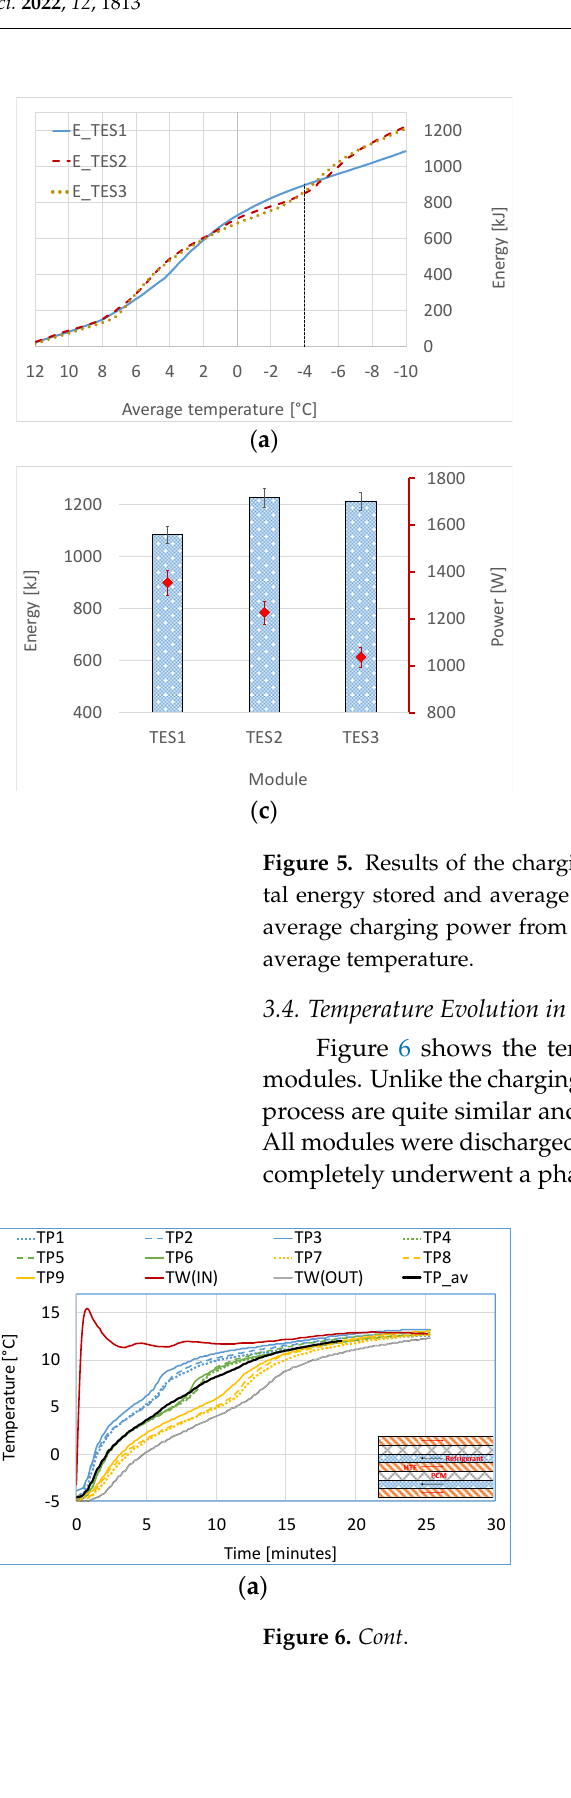
Figure 6. The temperature profiles of the discharging process for ( a ) TES (cid:2869) , ( b ) TES (cid:2870) , ( c ) TES (cid:2871) , and ( d ) position of the temperature sensors. 3.5. Energy Storage and Power during the Discharging Process Figure 7 presents the energy discharged and the discharging power for the three modules. As the modules were discharged from − 4 °C to 12 °C, the highest energy storage capacity corresponded to TES (cid:2871) followed by TES (cid:2870) . This is expected because TES (cid:2871) and